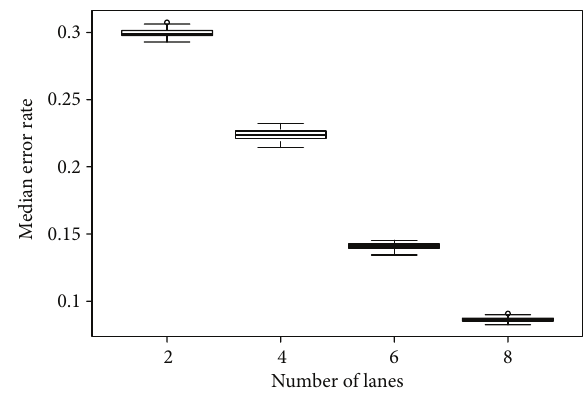
Figure 4: Median error rates for simulating 1000 exome sequences using different numbers of lanes. Simulation on 2 lanes shows nearly 30% error, and only around 5% error rate is observed for 16 lanes